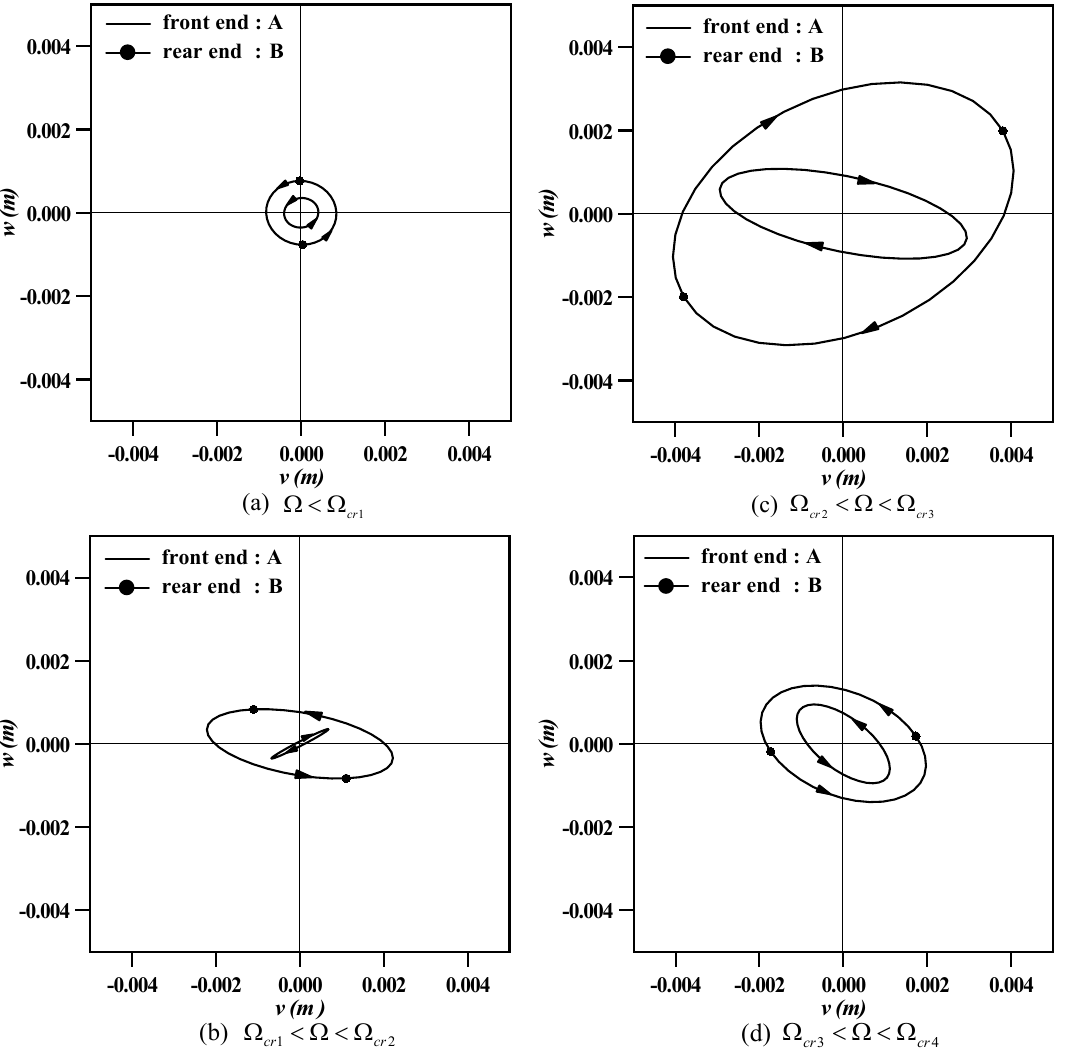
Fig. 9. Whirling orbits of global offset for different rotational